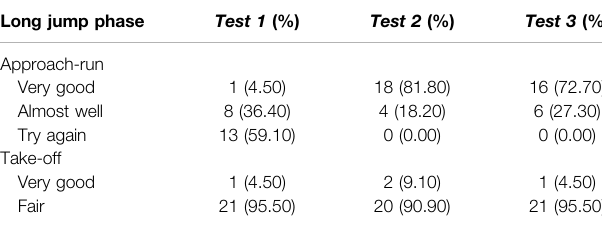
TABLE 3 | Percentage of the suggestion by the KBST system ( n (cid:1) 22). Long jump phase